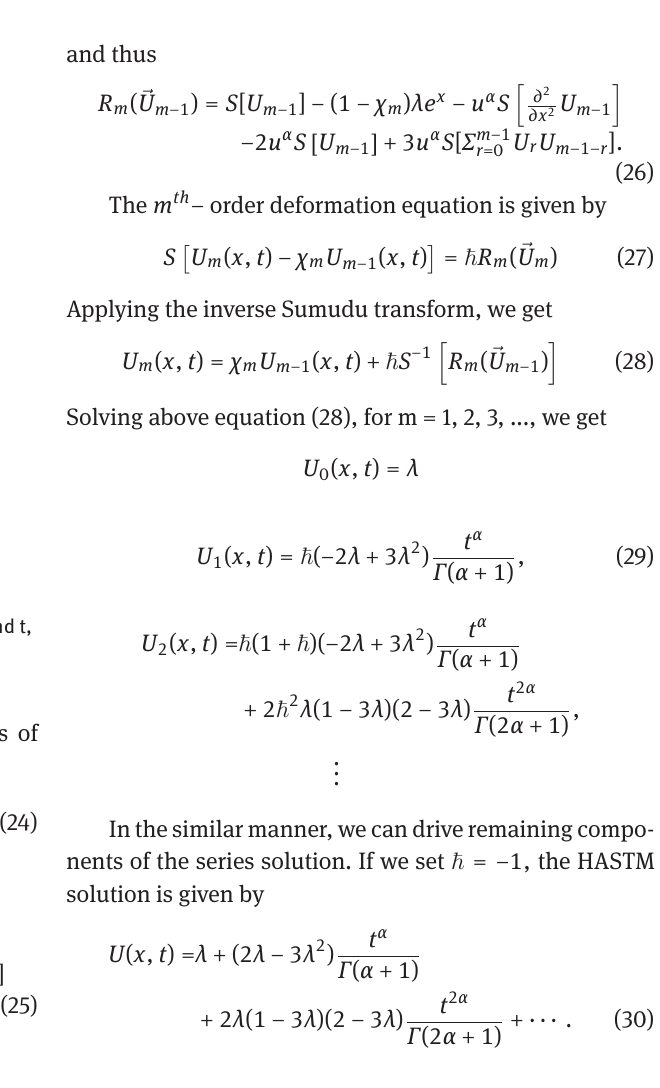
Fig. 1: The behavior of the exact solution U(x,t) w.r.t. x and t , when α = 1 for Eqs. (9)–(10).